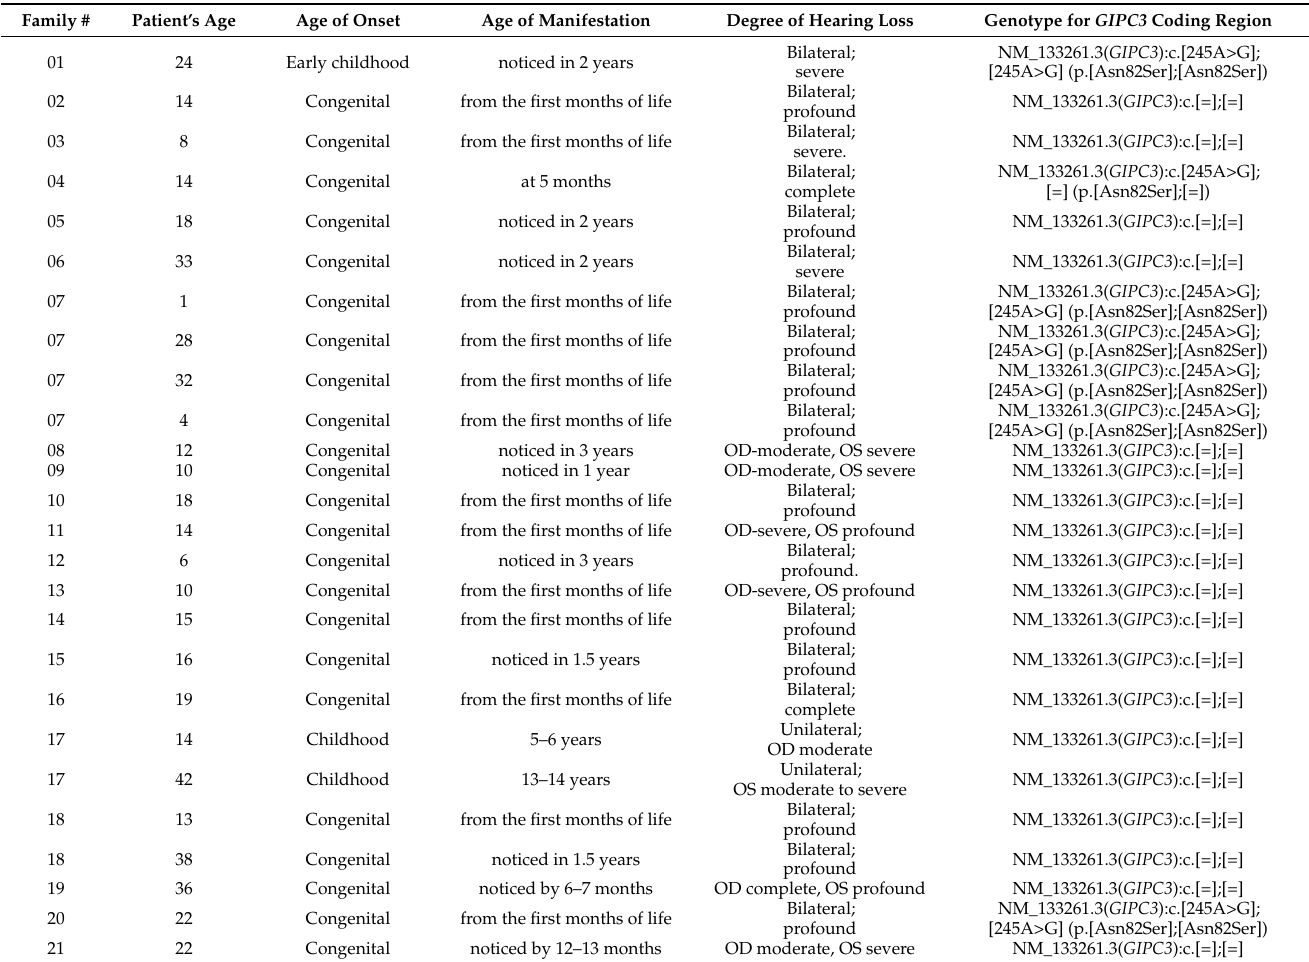
Table 1. Patients included in the